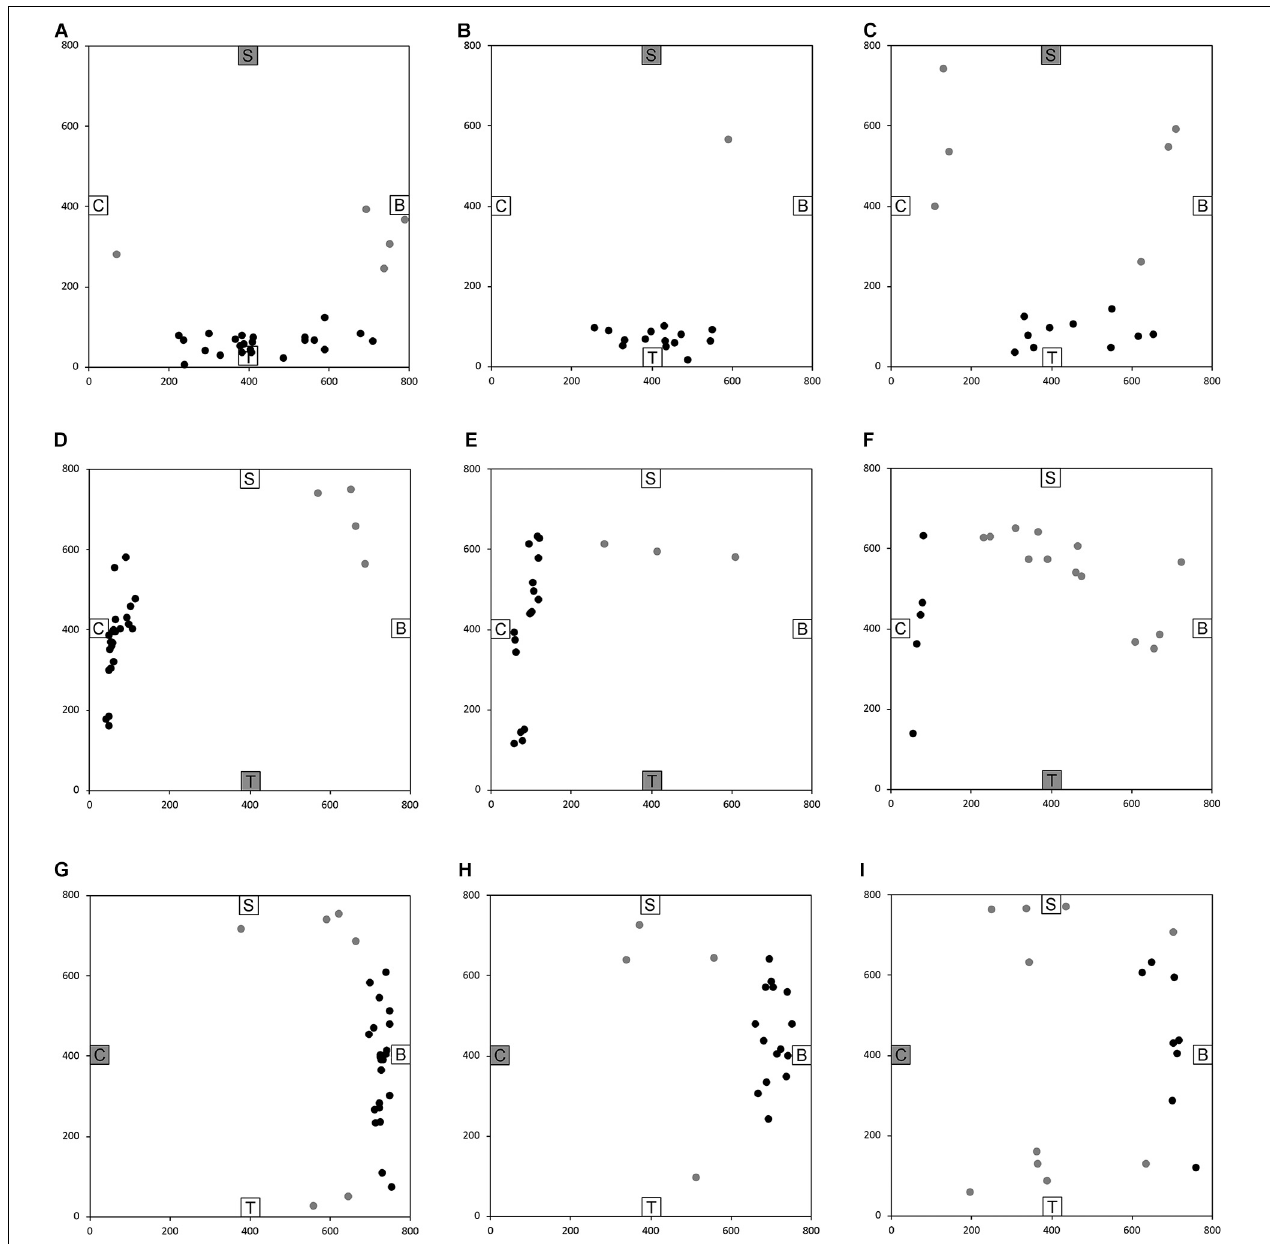
FIGURE 5 | End location of participants in the novel reverse path trials of the allocentric cognitive mapping task. (A) Shelf to Table, TD: 23/28 individuals ended in the quadrant of the room where the target object was located (black dot: in the correct quadrant; gray dot: in an incorrect quadrant). (B) Shelf to Table, DS: 18/19 individuals in the correct quadrant. (C) Shelf to Table, WS: 12/18 individuals in the correct quadrant. (D) Table to Chair, TD: 24/28 individuals in the correct quadrant. (E) Table to Chair, DS: 16/19 individuals in the correct quadrant. (F) Table to Chair, WS: 5/18 individuals in the correct quadrant. (G) Chair to Bench, TD: 22/28 individuals in the correct quadrant. (H) Chair to Bench, DS: 15/19 individuals in the correct quadrant. (I) Chair to Bench, WS: 8/18 in the correct quadrant. Room size: 800 cm × 800